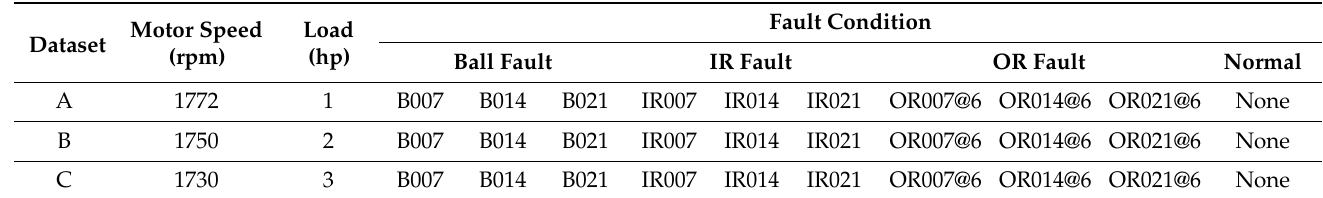
Table 1. Other necessary details of the dataset